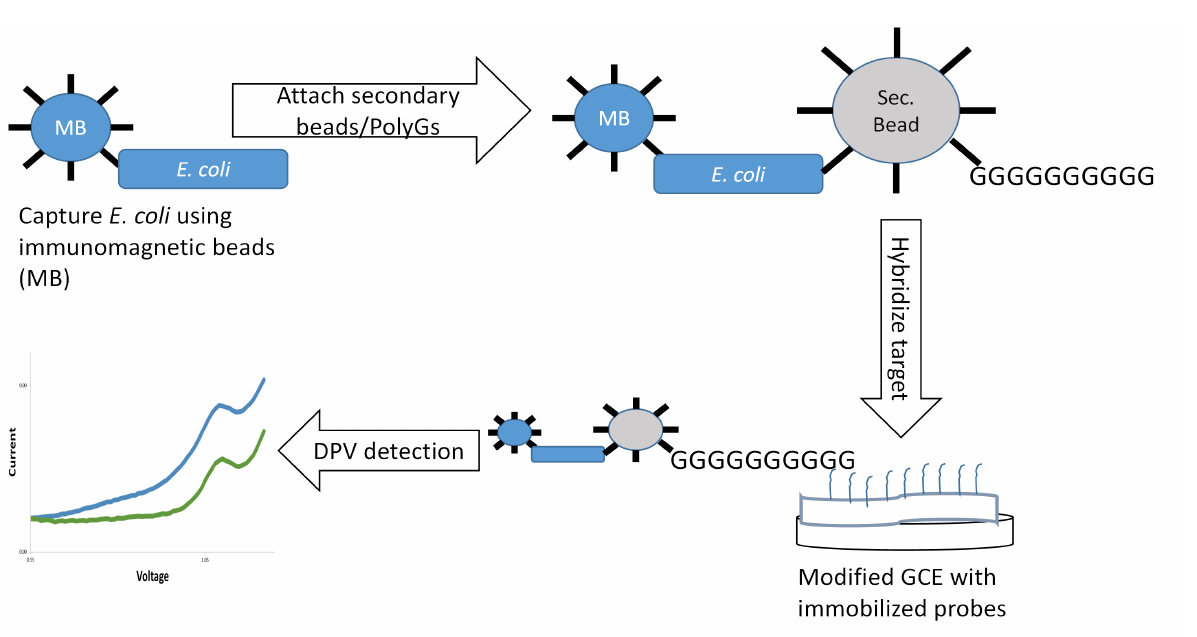
Figure 1. Working principle of the E. coli detection